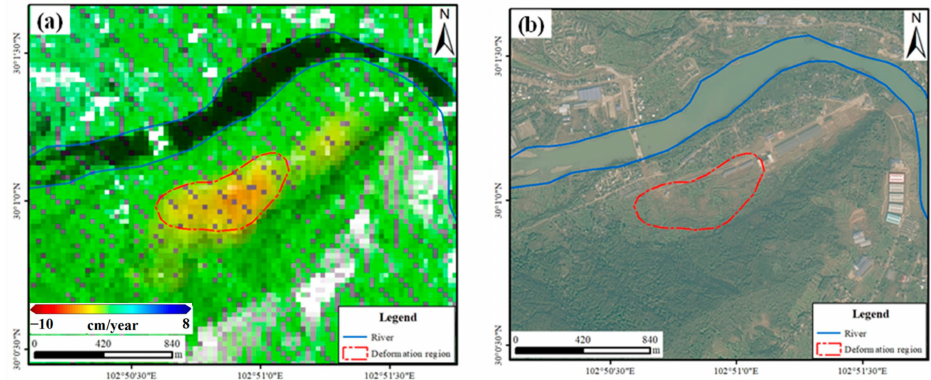
Figure 6. ( a ) Deformation map of the surface area from InSAR. ( b ) Optical satellite image of the ground deformation area on 1 February 2021.